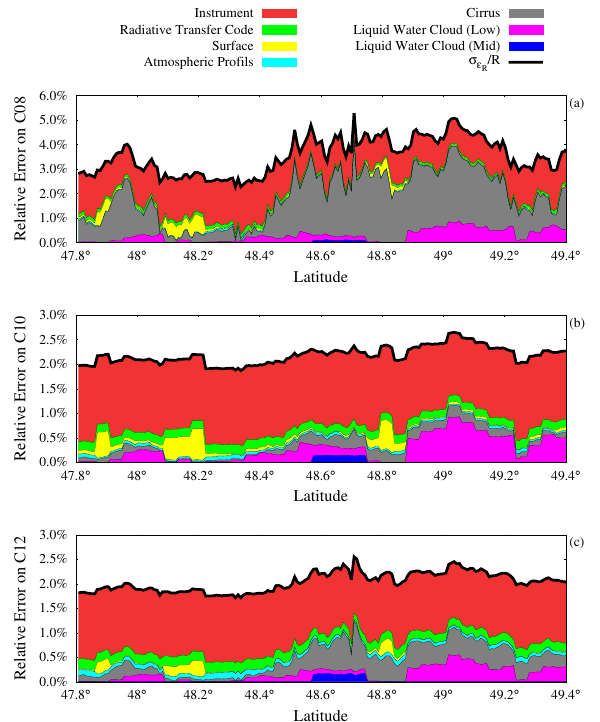
Fig. 3. Total relative errors (thick plain black line) associated to each measurement vector components corresponding to the 8.65µm (a) , 10.60µm (b) , and 12.05µm (c) channels of IIR, with the decompo- sition of their origins (in color patterns).